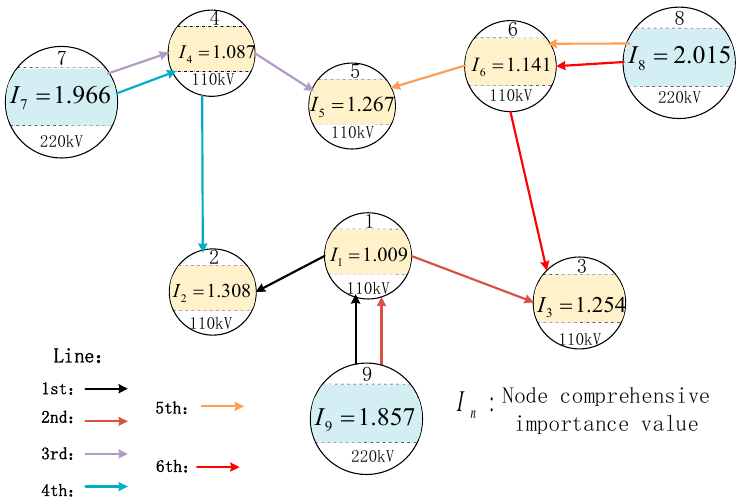
Figure 7. Node comprehensive importance lines.